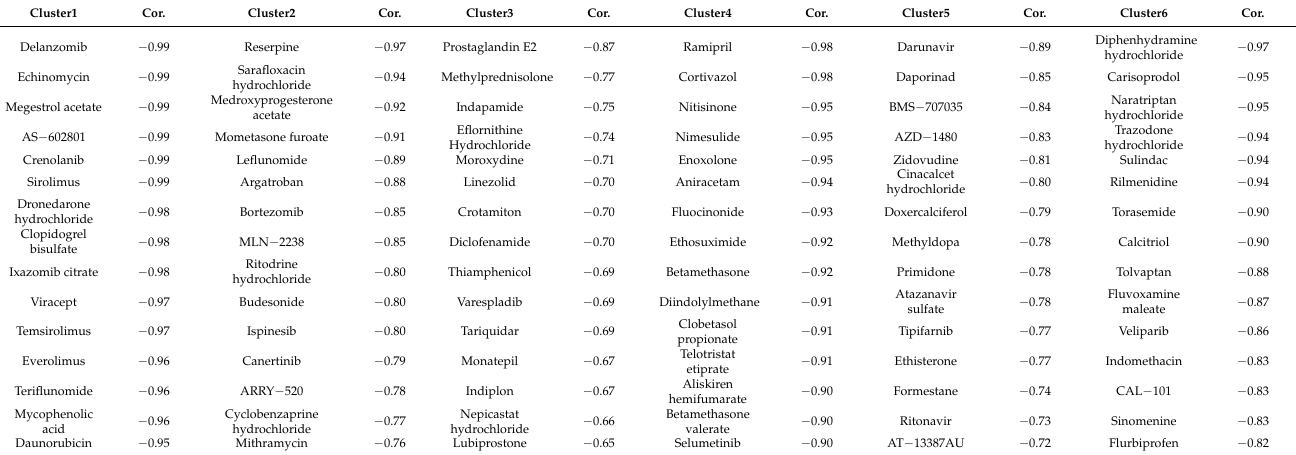
Table 1. The top 15 candidates in each drug